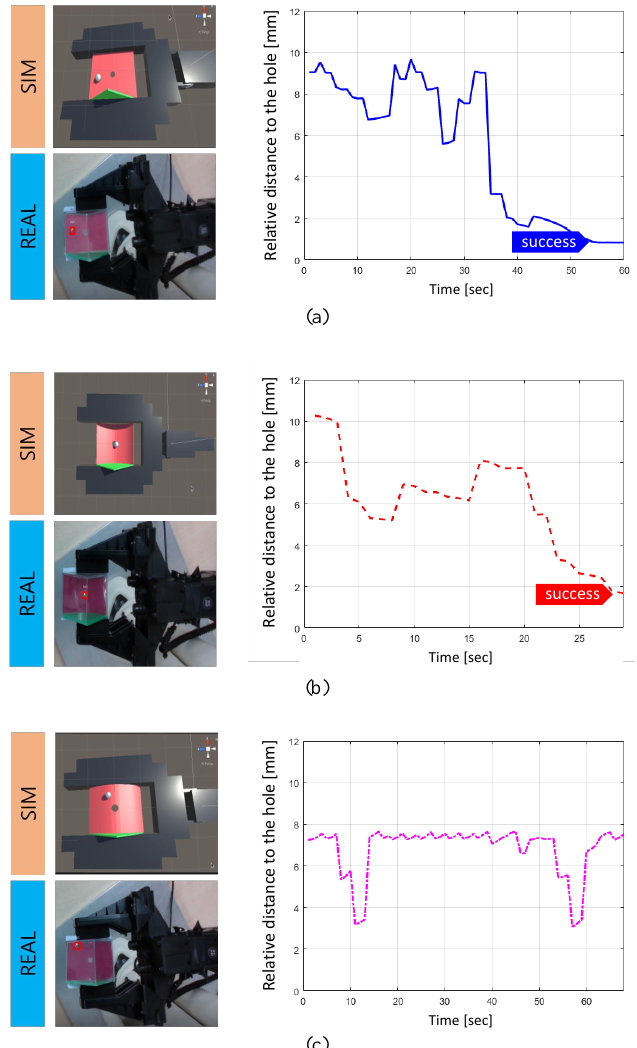
Figure 9. The sim- and the real-world scenes as well as the relative distance while the trained robotic agent is solving the real geduldspiele cubes: ( a ) flat plane, ( b ) convex plane, and ( c ) concave plane.